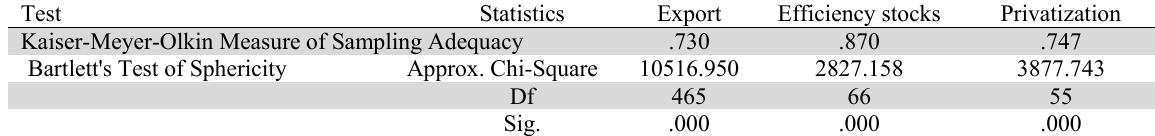
The summary of Kaiser-Meyer-Olkin Measure of Sampling Adequacy and Bartlett's Test Test